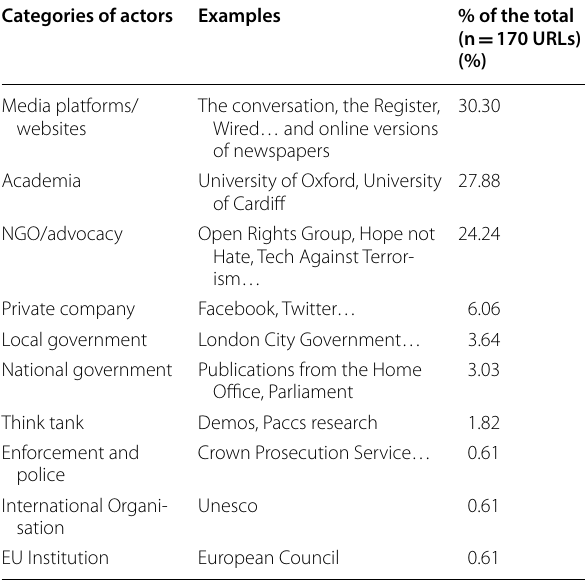
Table 5 Documents per type of actor (%) Categories of actors